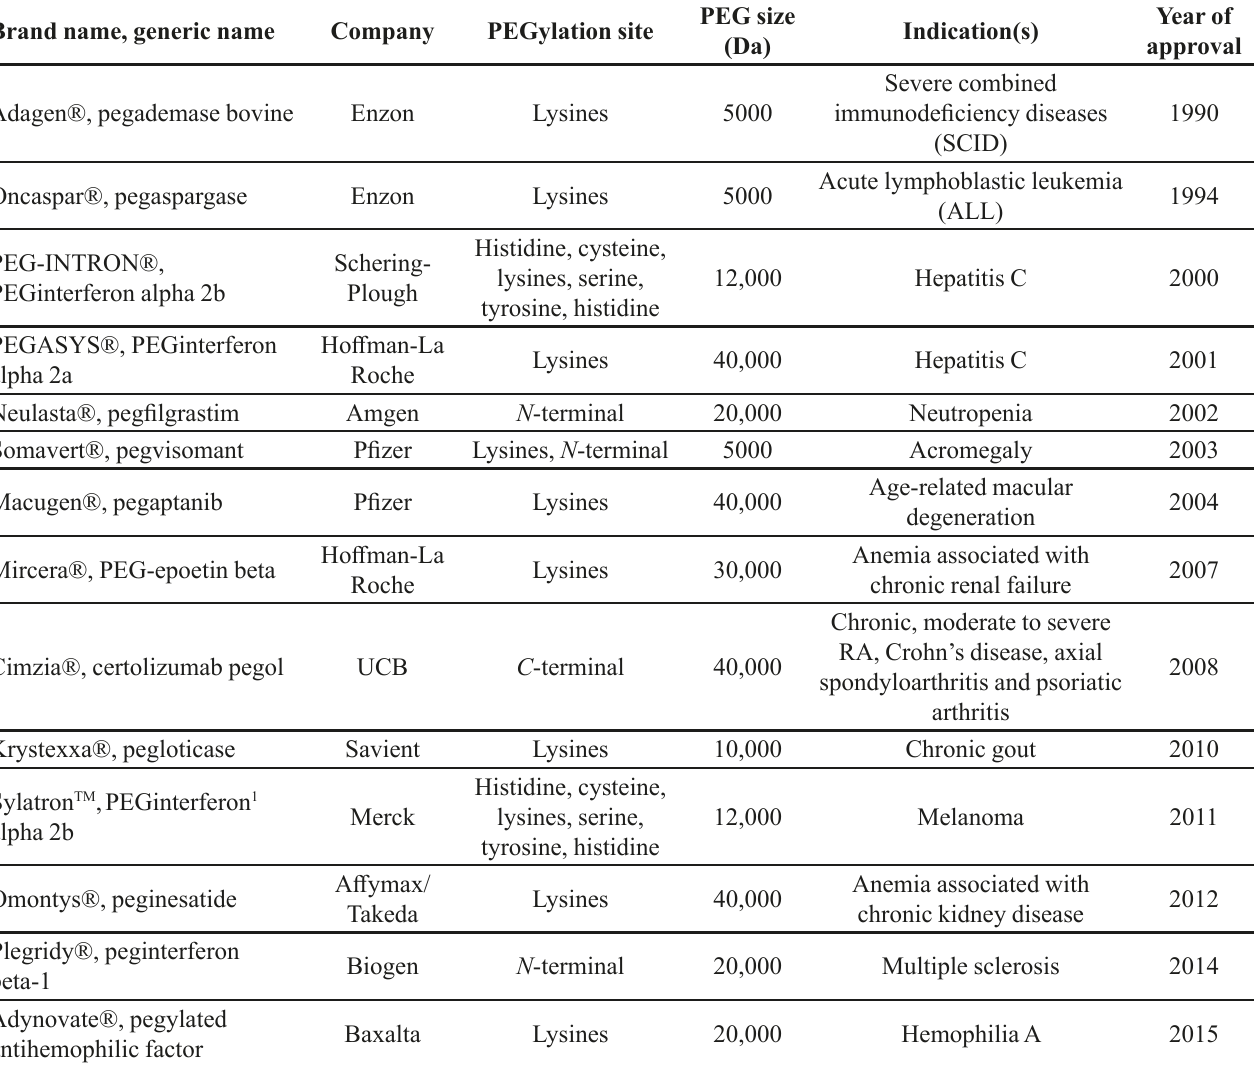
TABLE I - FDA-approved biotherapeutics PEGylated drugs in United and States and/or Europe Brand name, generic